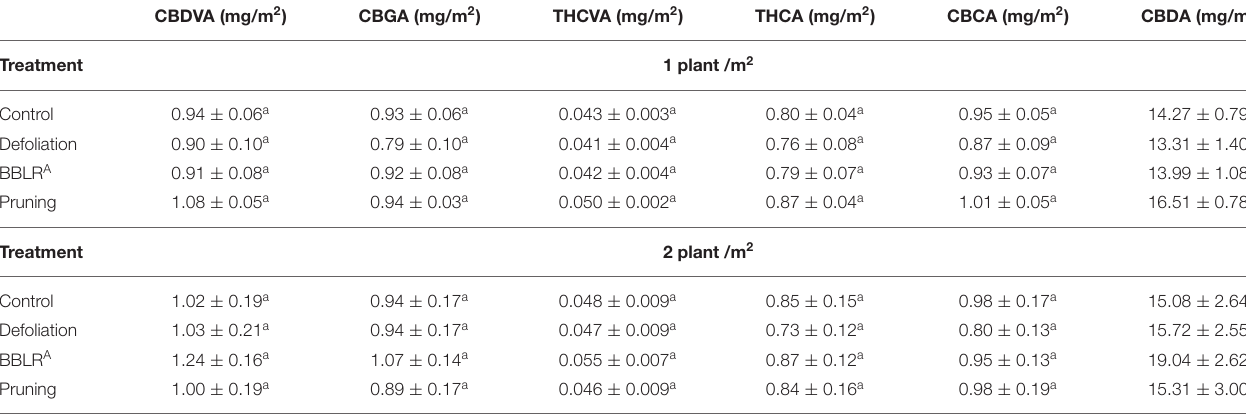
TABLE 2 | Cannabinoid yield per cultivation area (mg/m 2 ) as affected by plant density and architecture modulation treatments B